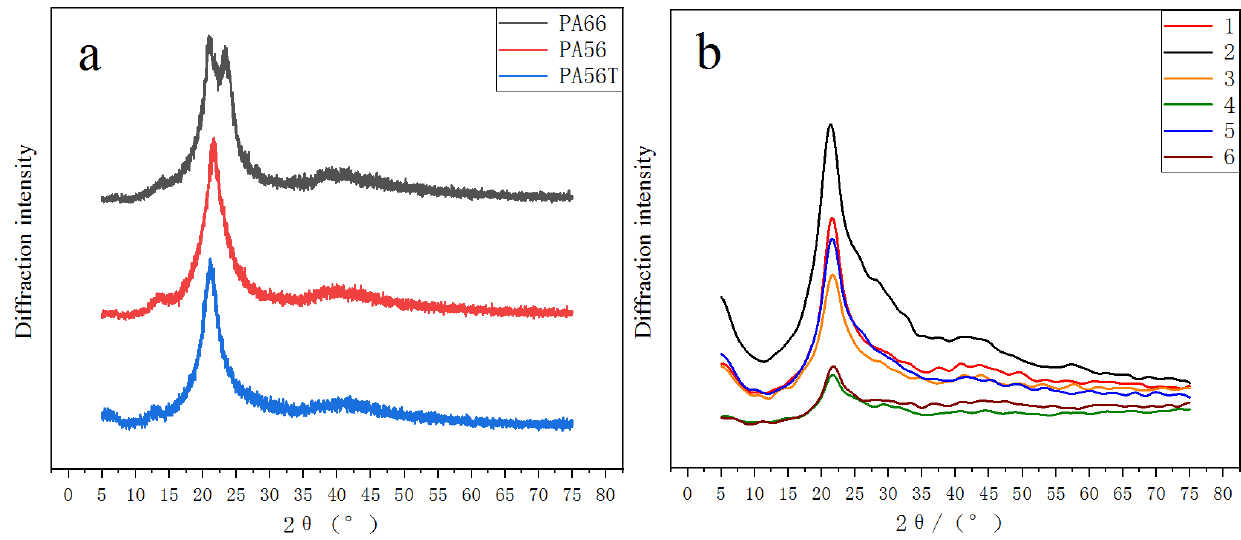
Figure 3. XRD diffraction pattern ( a ) XRD diffraction peaks of PA56, PA66, PA56T, ( b ) XRD diffraction peaks of samples with different antioxidants.